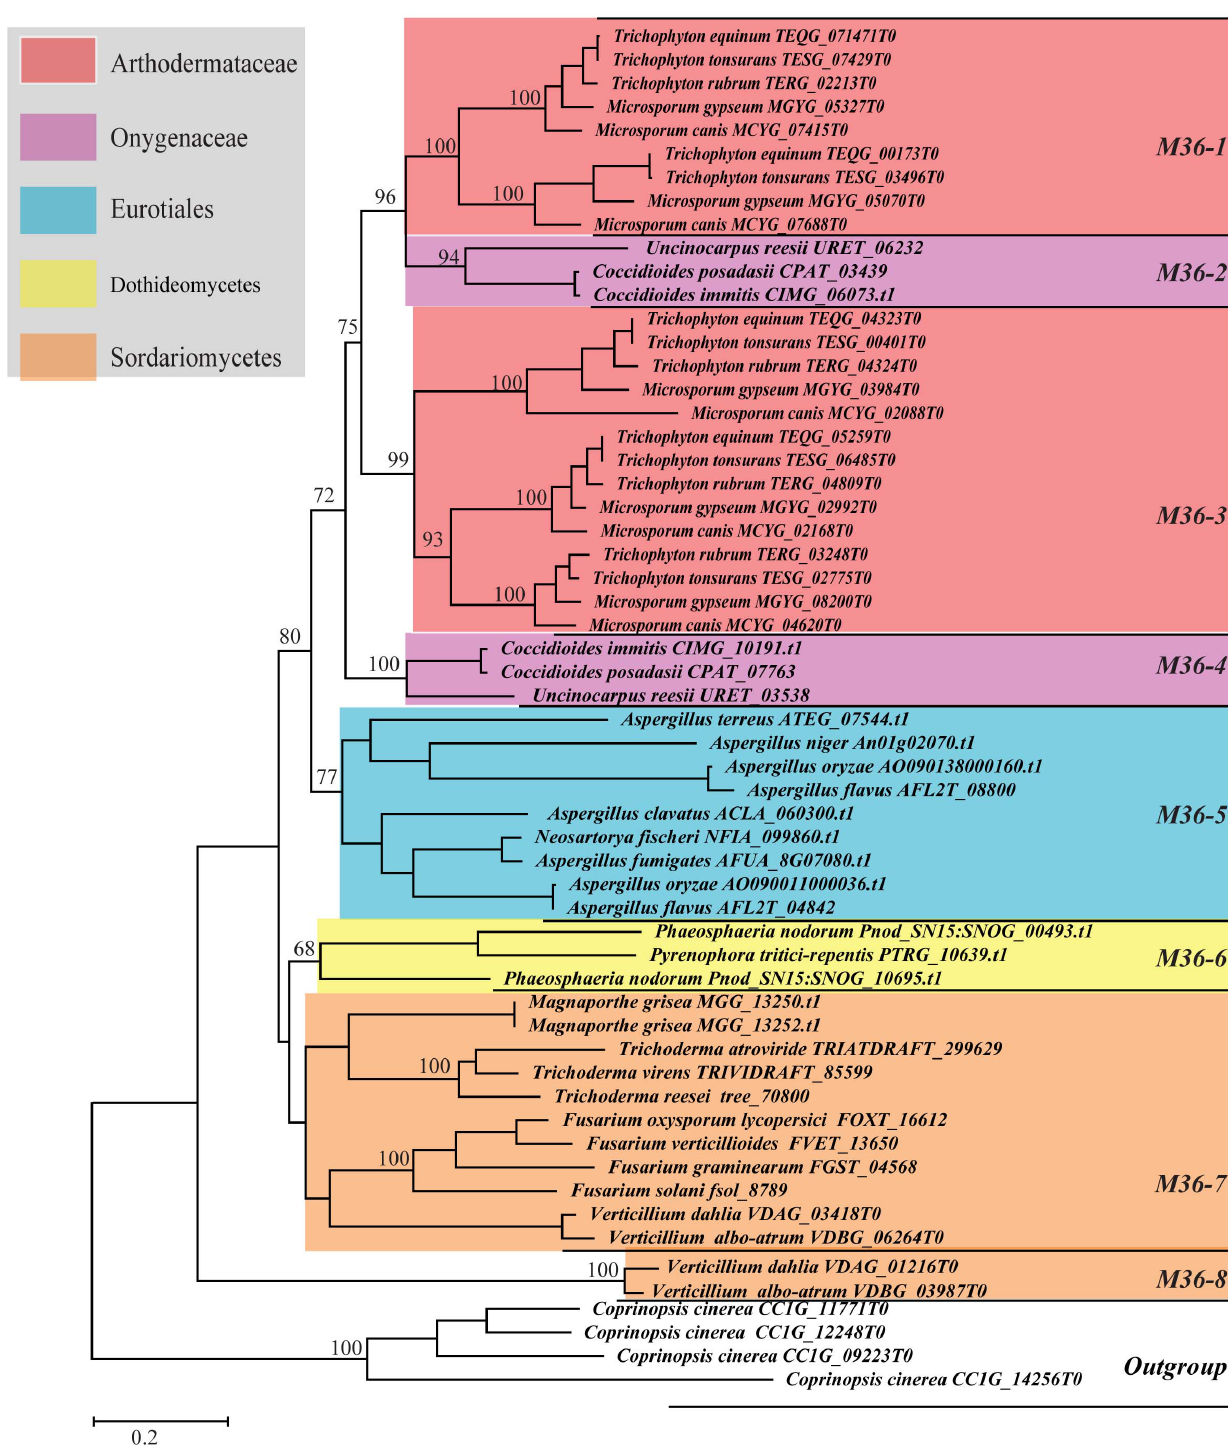
Figure 2. ML tree based on amino acid sequences of 58 M36 family genes. The tree was performed using PHYML 3.0[17]. The best-fitting model WAG + I + G and their parameters (I=0.038, G=1.149) which were estimated by program ProtTest [50] were used in the ML analysis. The reliability of the tree topology was evaluated using bootstrap support [20] with 100.